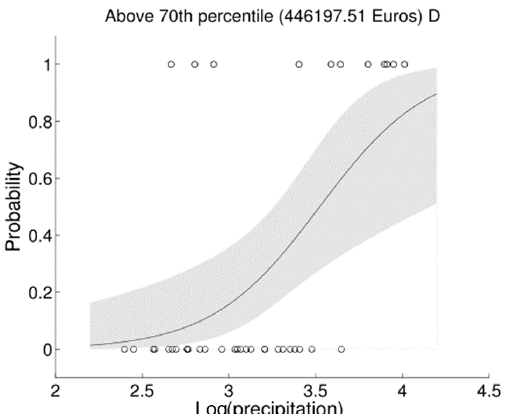
Figure 7. Example of a logistic regression result used to model damages ( D ) above the 70th percentile as a function of 30min pre- cipitation in units of log (mm) for the MAB. The solid line indi- cates the best estimate while the shaded band indicates the 95% confidence interval. Open circles along the horizontal axis show the events that are above (top) and below (bottom) the percentile